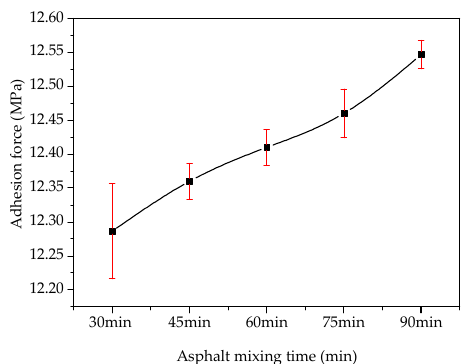
Figure 4. Effect of mixing time on the adhesion at the asphalt–steel slag interface. Figure 4. E ff ect of mixing time on the adhesion at the asphalt–steel slag interface. Materials 2020 , 13 , x FOR PEER REVIEW